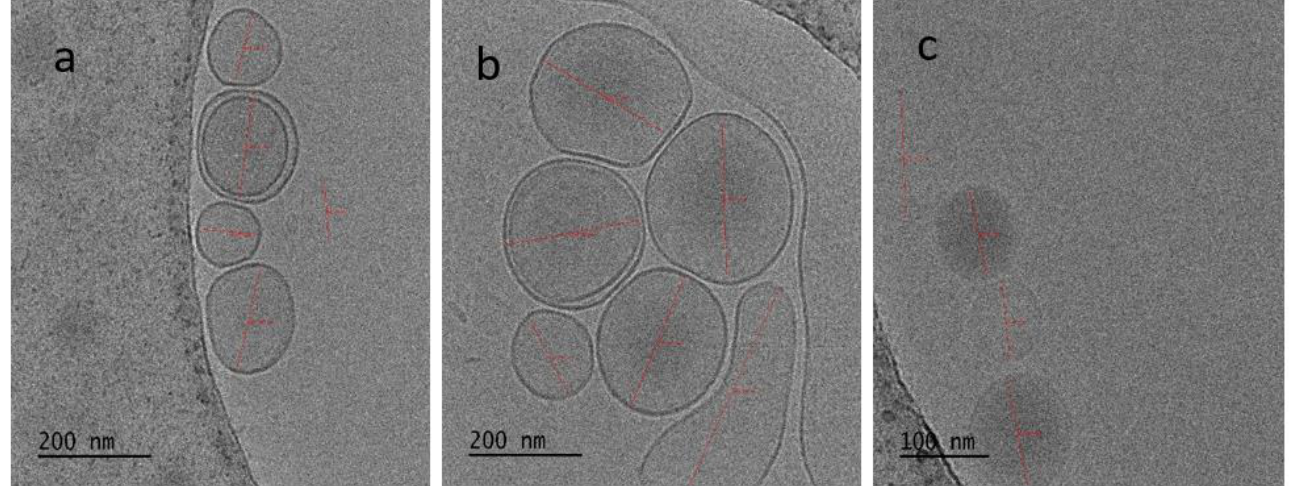
Figure 1. Cryo-electron microscopic images showing the surface morphology of CHX liposomes. ( a , b ) Cryo-EM images of multiple liposomes at 200 nm scale in which the lipid bilayer is also visible and ( c ) Cryo-EM image of liposomes at 100 nm scale.